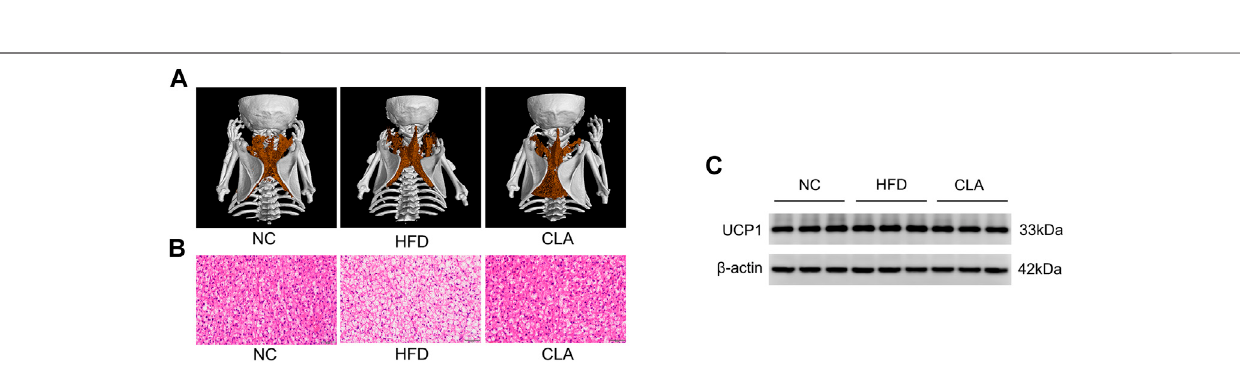
FIGURE4| EffectofCLAontheBATfunctionofmicegivenaHFD. (A) Representativethree-dimensionalimagesofBATreconstructedviamicroCT. (B) Representative H and E staining of BAT sections. Original magni fi cation, × 400. Scale bar, 20 μ m. (C) Detection of UCP1 expression in BAT by Western-blotting ( n (cid:2) 3 in each group).